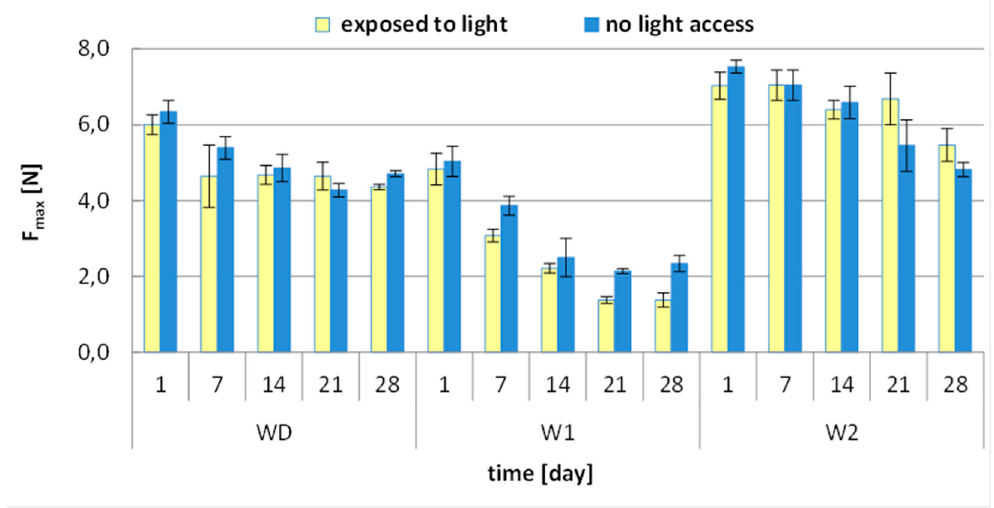
Figure 3. Effect of light on mechanical durability of capsules containing 6 g goethite/1.5 mL − 1 alginate.